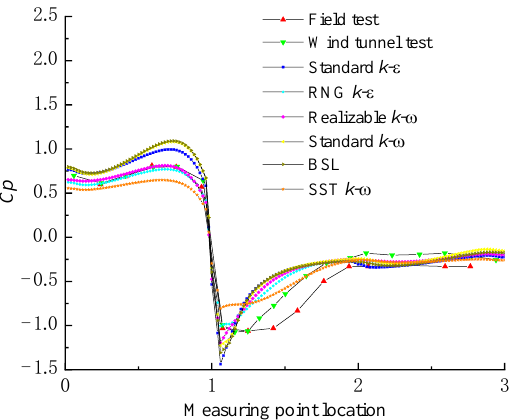
Figure 3. Wind pressure distribution curves with different turbulence models. Table 4. Wind pressure coefficients from different methods.